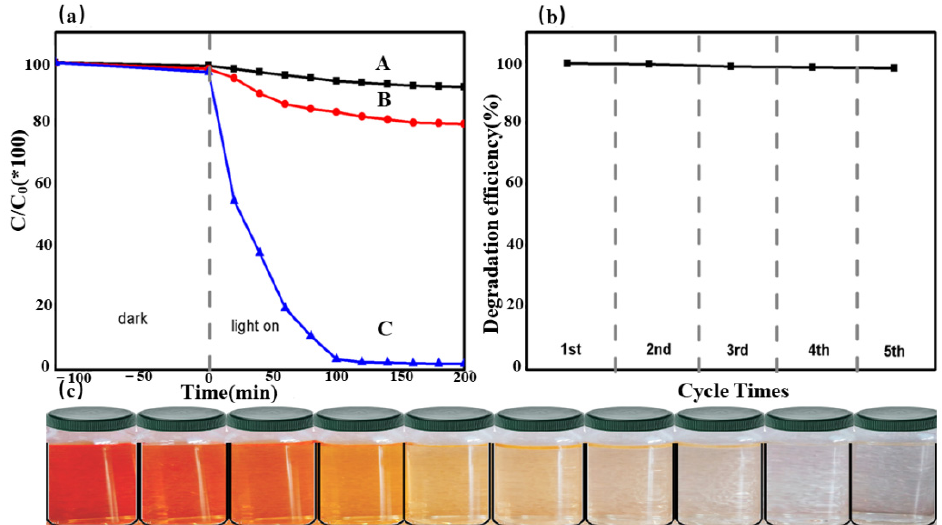
Figure 4. ( a ) Absorption of Methyl orange in the dark and consequent photocatalytic degradation without photocatalyst (A), with the blending of PAN and PW12 (B), in the presence of PW-PIL (C) under visible light irradiation; ( b ) Recyclability of the supported photocatalyst PW-PIL. Concentration of the photocatalyst is 1 mg mL − 1 (20 mg in 20 mL aqueous solution); concentration of MO is 50 ppm; on average, five samples are taken in 100 min; ( c ) Appearance of methyl orange aqueous solution during the photocatalytic degradation process at an interval of 10 min.